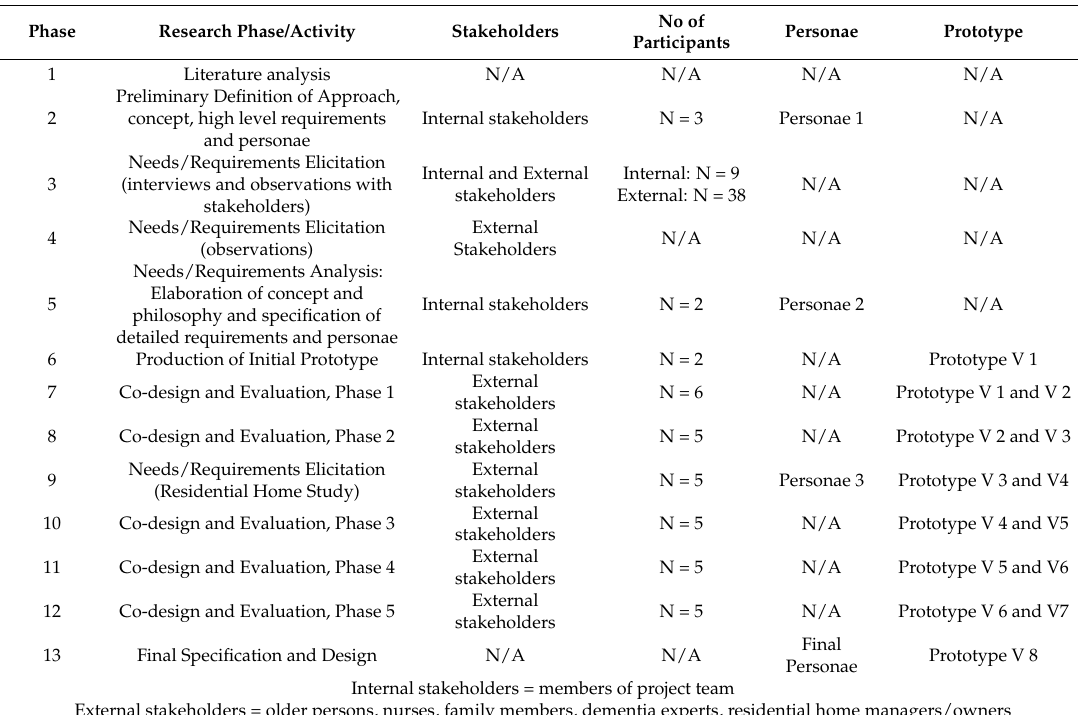
Table A1. Overview of study 1a research phases and activities.